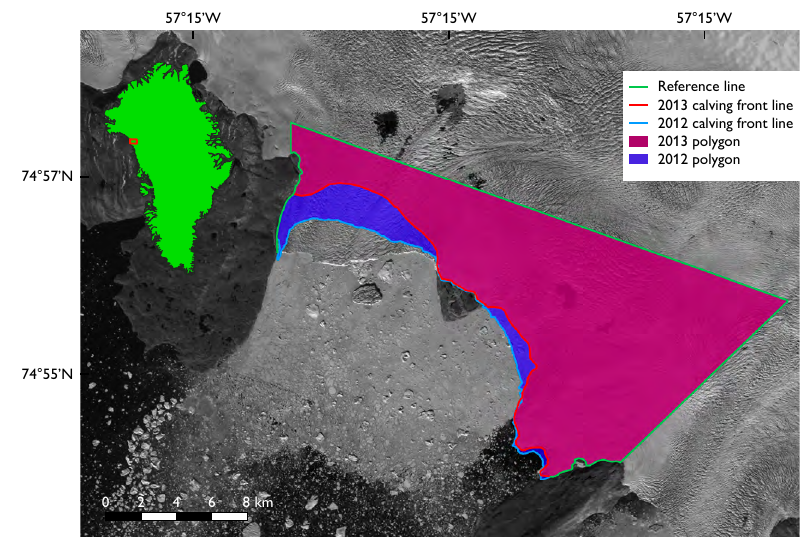
Fig. 2: Example image from Hayes glacier Table 2: Overview of net area change, average annual area change, showing how area change is estimated from two and width for the 47 tidewater glaciers monitored between consecutive calving front lines. The green line 1999–2018. indicates the reference line. The calving front lines in 2012 and 2013 are depicted by blue and red lines, respectively. The glacier area change (km 2 ) (km 2 a -1 ) is computed as the area difference between the 2012 and 2013 polygons. The satellite image is an EU Copernicus Sentinel-2A image from